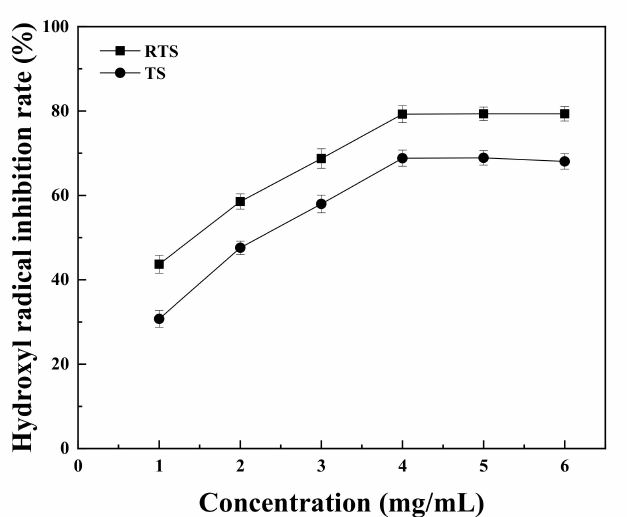
Figure 8. The hydroxyl radical scavenging activity levels of TS and